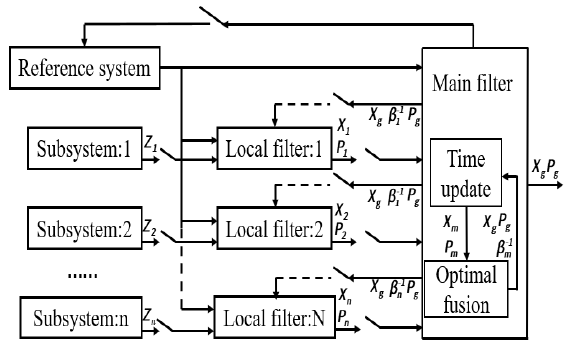
Figure 2. The block diagram of the federated